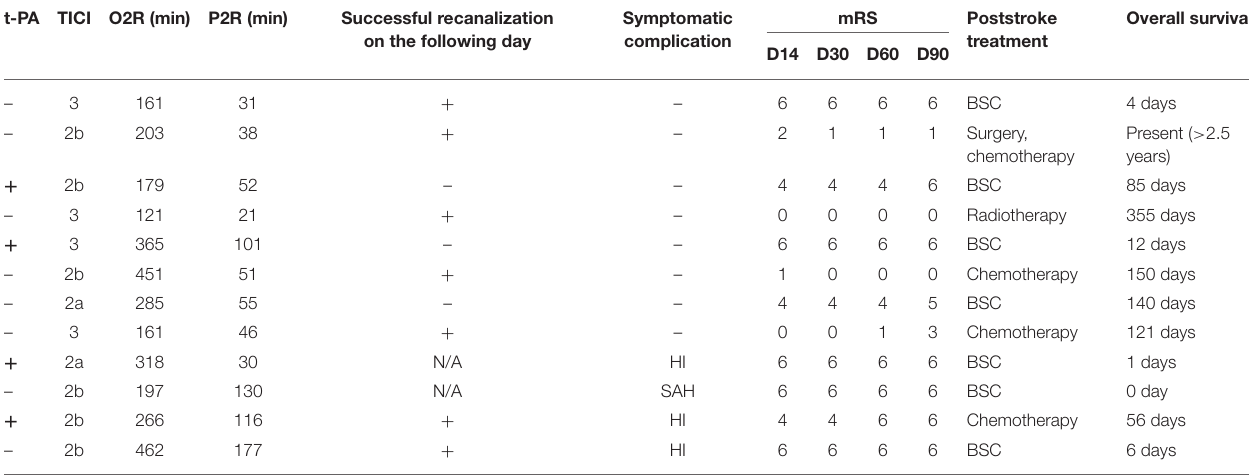
TABLE 2 | Treatment results.